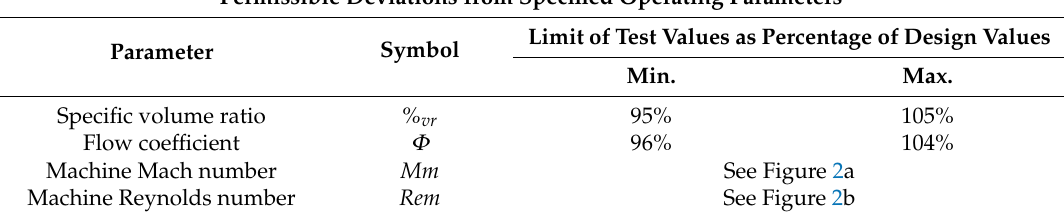
Table 1. Permissible deviations from specified operating parameters [15].